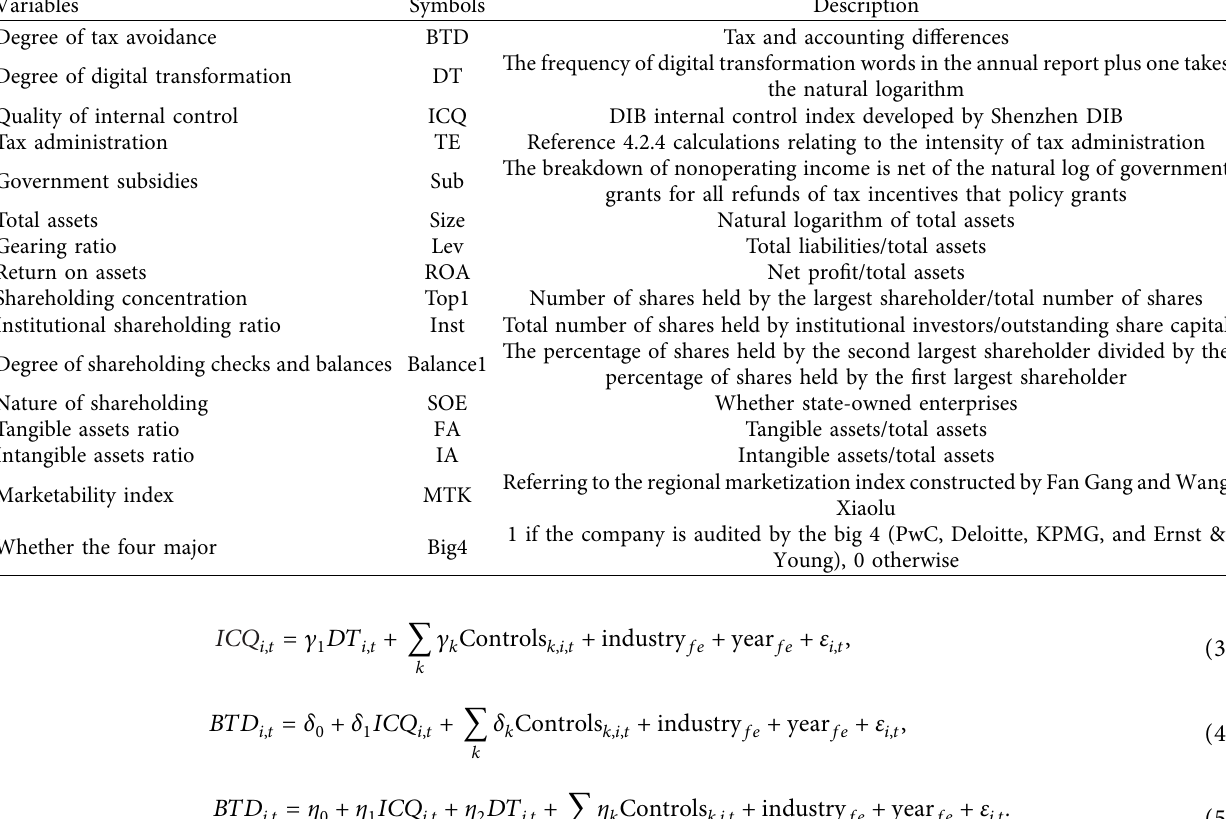
Table 1: Main variable symbols and